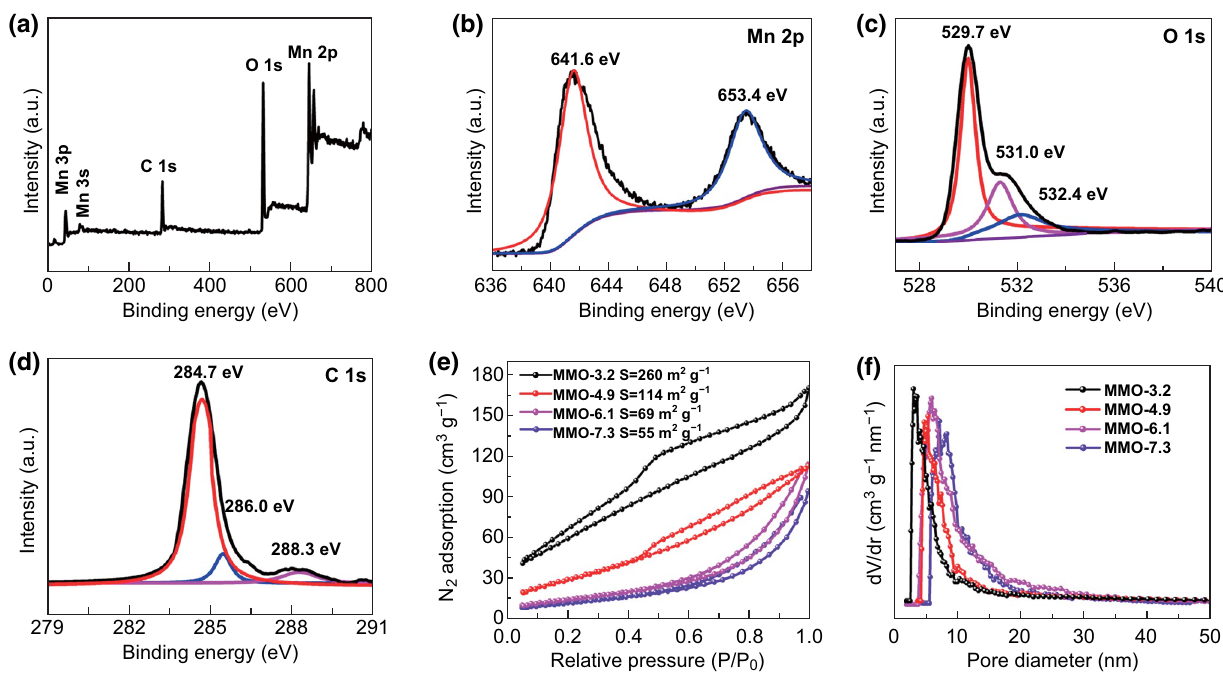
Fig. 3 XPS spectrum of MMO‑3.2: a survey spectrum, b manganese peaks Mn 2 p 3/2 and Mn 2 p 1/2 , c oxygen (O 1 s ) and d carbon (C 1 s ). e , f Nitrogen sorption isotherms and corresponding pore‑size distribution curves of the